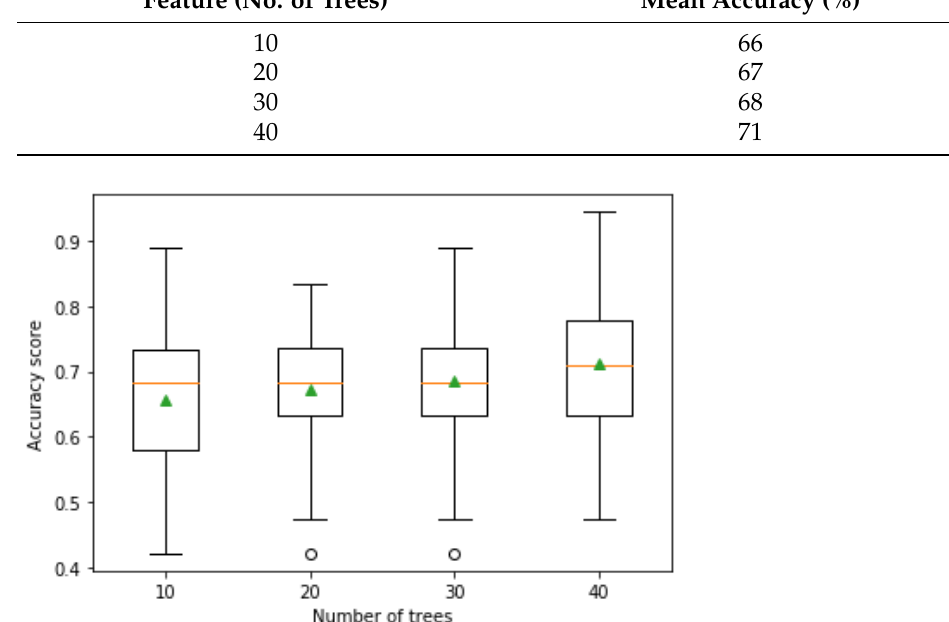
Figure 23. Nepal: Boxplot represents the mean accuracy distribution achieved by tuning the number of trees for every